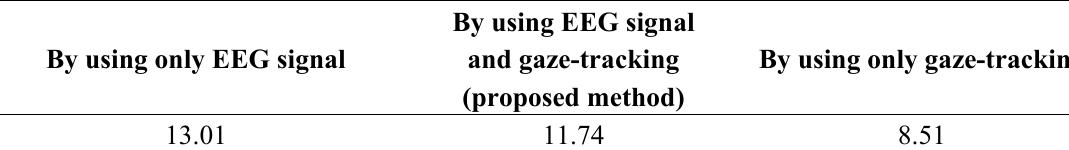
Table 6. Comparisons of average processing times of various methods (unit: s).